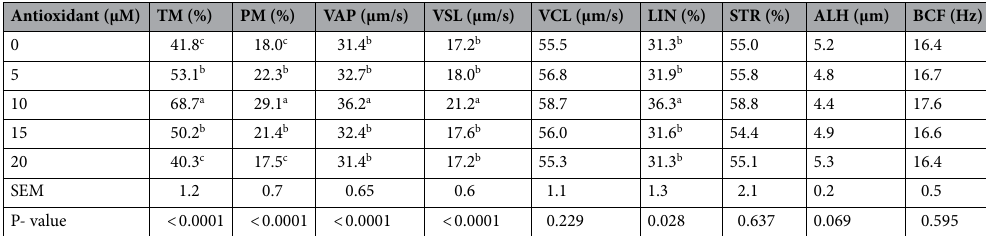
Biochemical parameters. Figure 1d–g indicate the data related to ROS, superoxide dismutase (SOD) and glutathione peroxidase (GPx) activities and total antioxidant capacity (TAC), respectively. In case of ROS, 10 µM tempol (2.7 ± 0.05) illustrated lower ROS compared to other groups (P < 0.05). No significant difference (P > 0.05) was detected among groups in case of SOD. For GPx and TAC, 10 µM tempol (62.8 ± 1.1 and 2.0 ± 0.06, respectively) presented the highest GPx and TAC among groups. Effect of straw size on sperm parameters. The effect of straw size on motile parameters after cry- opreservation are displayed in Table 3. Total and progressive motility were significantly higher in 0.5 straw size (52.2 ± 0.7 and 22.7 ± 0.4, respectively) compared to 0.25 straw size (P < 0.05). Straw size did not have any significant effects on VAP, VSL, LIN, VCL, STR, ALH and BCF (P > 0.05). The membrane integrity and mito- chondria activity of sperm cryopreserved with 0.5 straw size (50.6 ± 0.6 and 48.9 ± 0.7, respectively) had better performance compared to 0.25 straw size (Table 4) (P < 0.05). Based on the data shown in Table 5, the minimum ROS is observed in the group of 0.5 straw size (3.5 ± 0.03) (P < 0.05). But straw size did not have any significant effects on the GPx and SOD activities and TAC of frozen-thawed sperm (P > 0.05). Effect of straw size on viable, and apoptotic-like changes, and dead of rooster sperm after cryopreservation are presented in Table 6. When